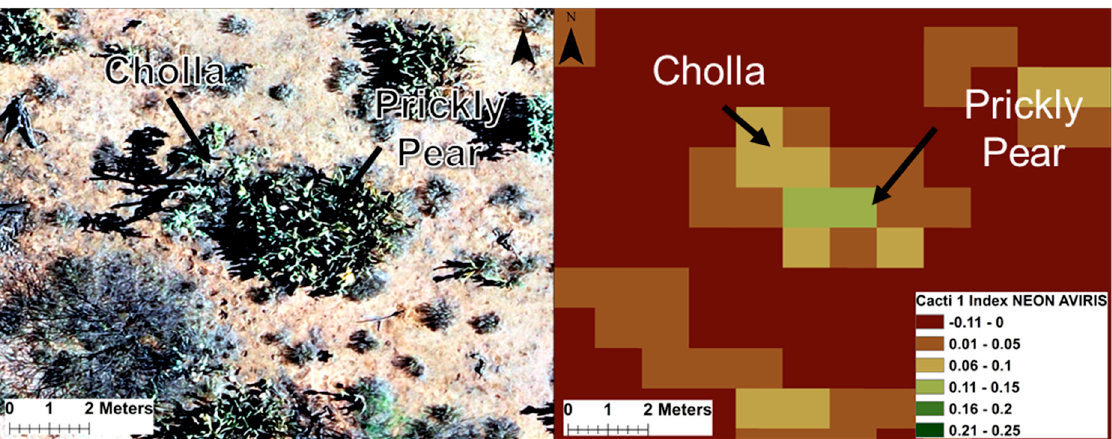
Figure 5. On the left : Example of a prickly pear cactus and a cholla cactus as captured by the DJI Mavic Pro Quadcopter. The nominal spatial resolution of the image is 1.6 cm. The difference in structure between the cholla and prickly pear is clear as seen by the influence of shadowing on the prickly pear cactus. On the right : The Cacti Index 1 visualized using the 1 m NEON AVIRIS reflectance data. It can be seen that cholla and prickly pear have higher cacti index values.